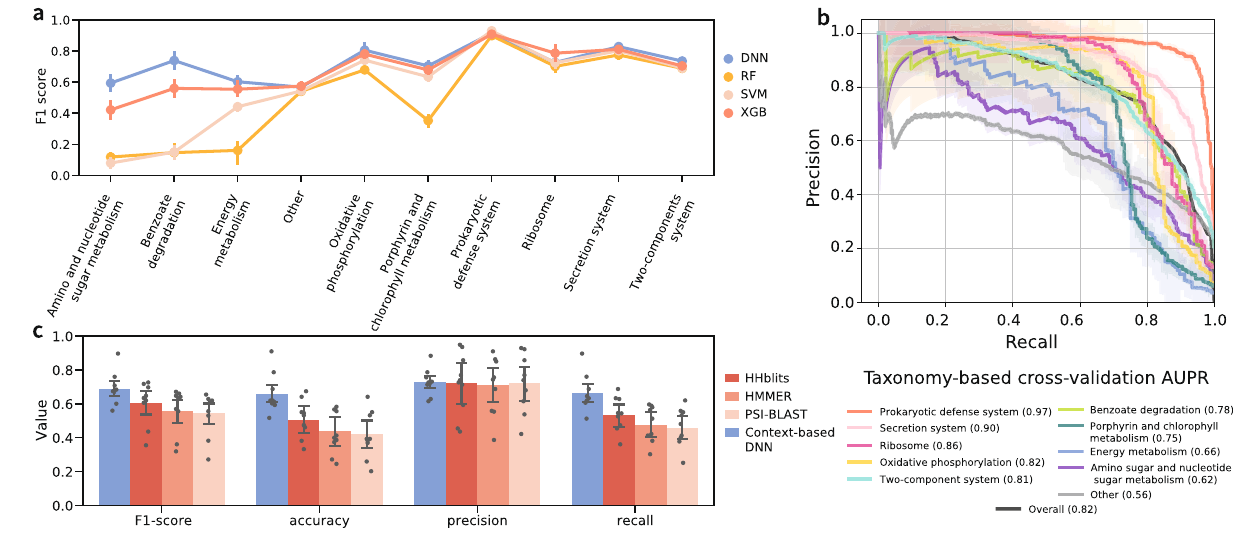
Fig. 3 | Embedding-based function prediction performance assessment and benchmarking.a Classi fi ercomparison.F1scoreswereobtainedforeachcategory usingtheleave-one-taxonomic-group-outcross-validation.Eachdotrepresentsthe average with error bars of ±1SD obtained from the n =5 folds. DNN deep neural network, RF random forest, SVM support vector machine, XGB XGBoost. b Precision – recall curves per functional category calculated using leave-one-taxo- nomic-group-out cross-validation (see also Supplementary Fig. 2). The “ Overall ” group refers to the micro-average of all categories combined (i.e., aggregating the